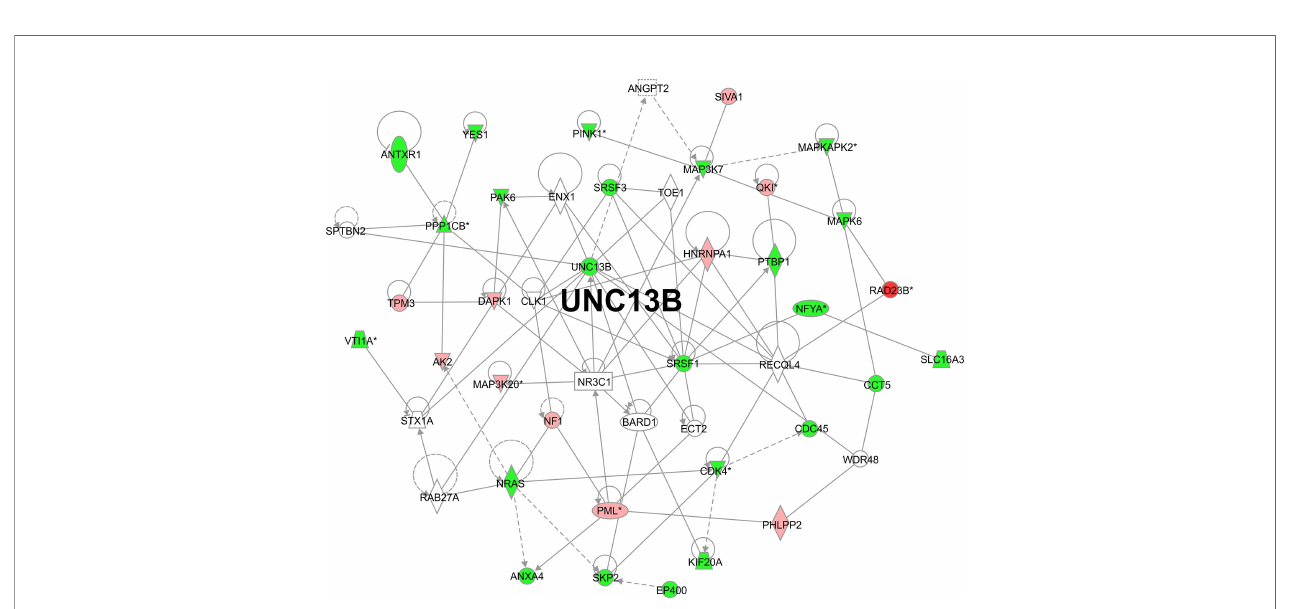
FIGURE 5 | Gene interaction network based on ingenuity pathway analysis. *p<0.05.